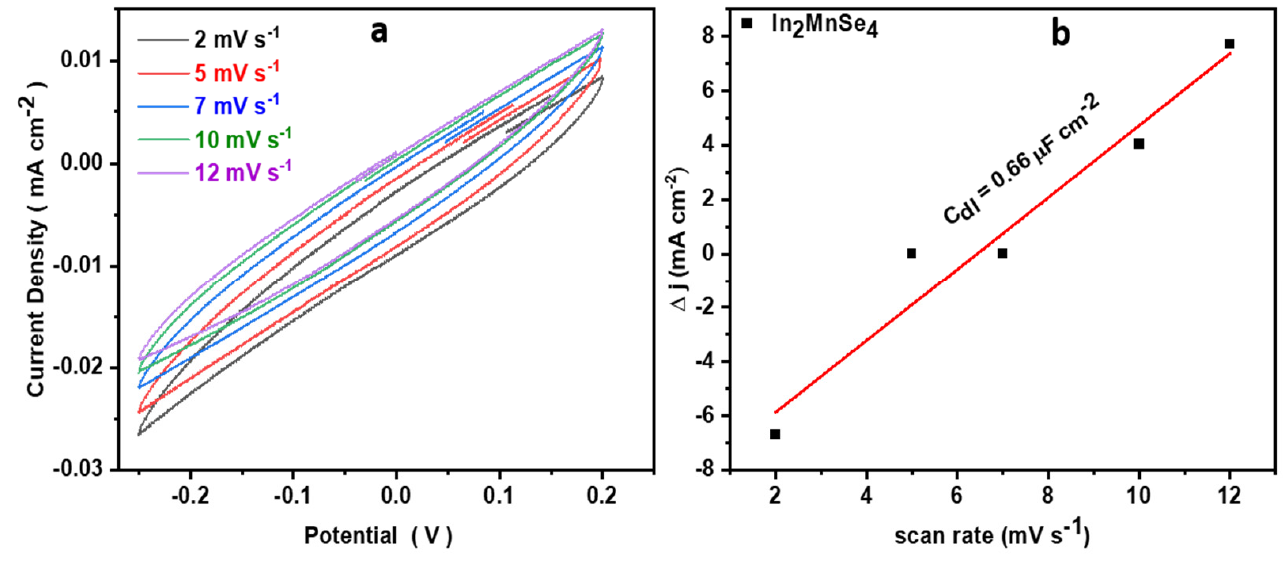
Figure 7. Electrochemical active surface area test (ECSA) ( a ) CV data with multiple scan rate and ( b ) electrochemical double layer capacity (C dl ) of In 2 MnSe 4.